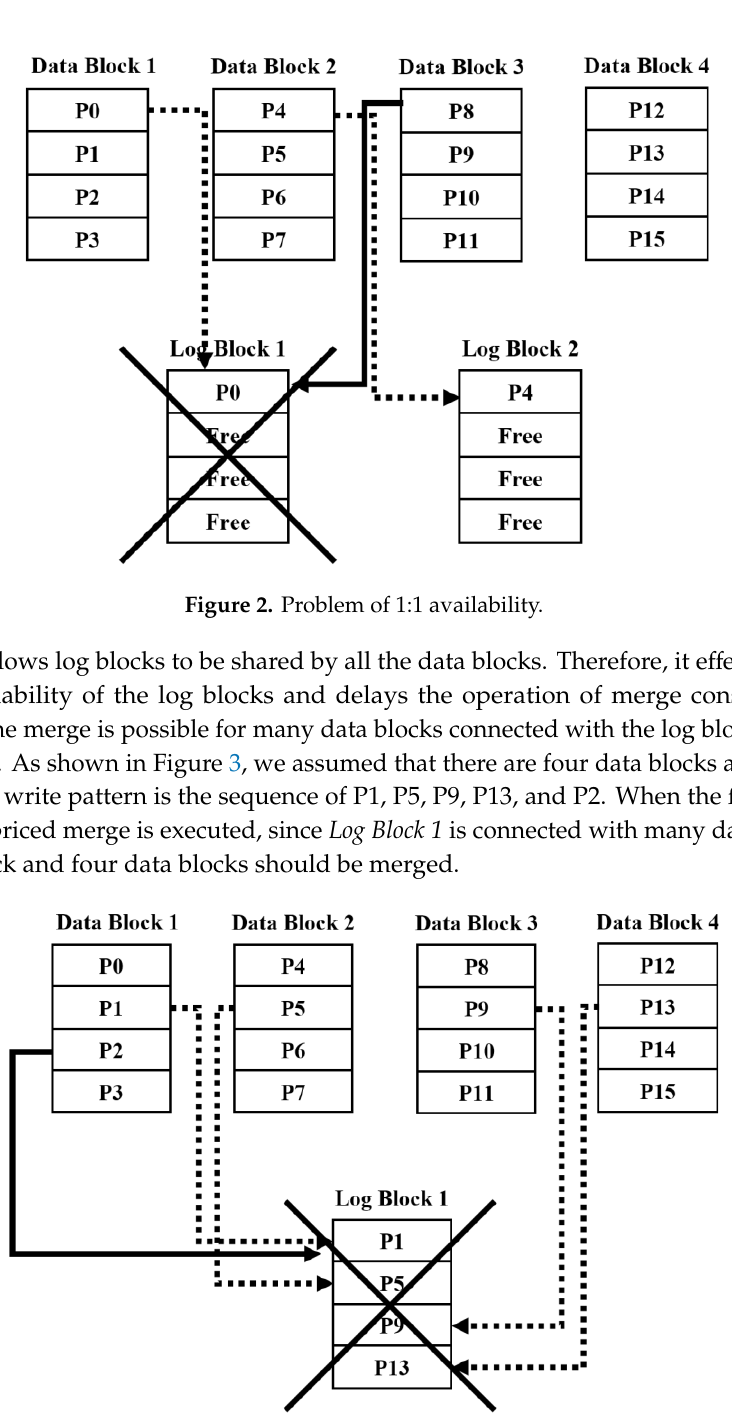
Figure 3. Problem of M:N availability.